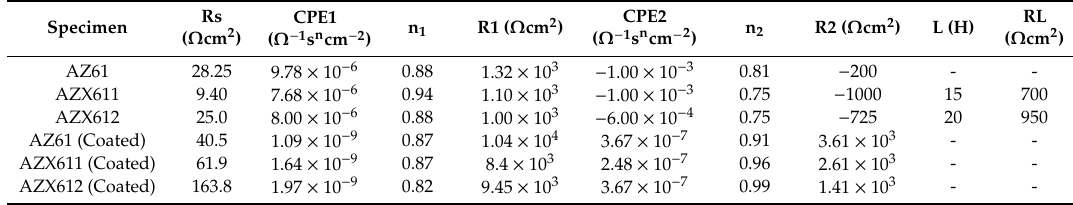
Figure 8. Electrochemical impedance spectra of coated specimens of AZ61, AZX611, and AZX612 specimens: ( a ) Nyquist plots, ( b ) bode plots, and ( c ) phase plots, and ( d ) the equivalent circuit. Table 3. Parameter of the fitted plotting of EIS spectra.